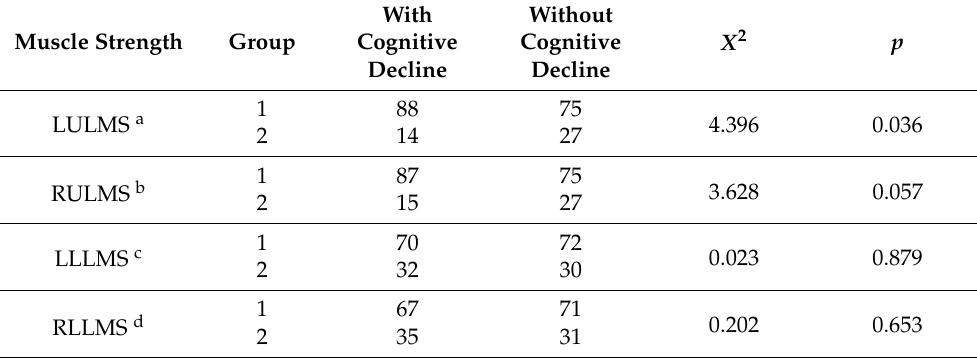
Legend: a —left upper limb muscle strength; b —right upper limb muscle strength; c —left lower limb muscle strength; d —right lower limb muscle